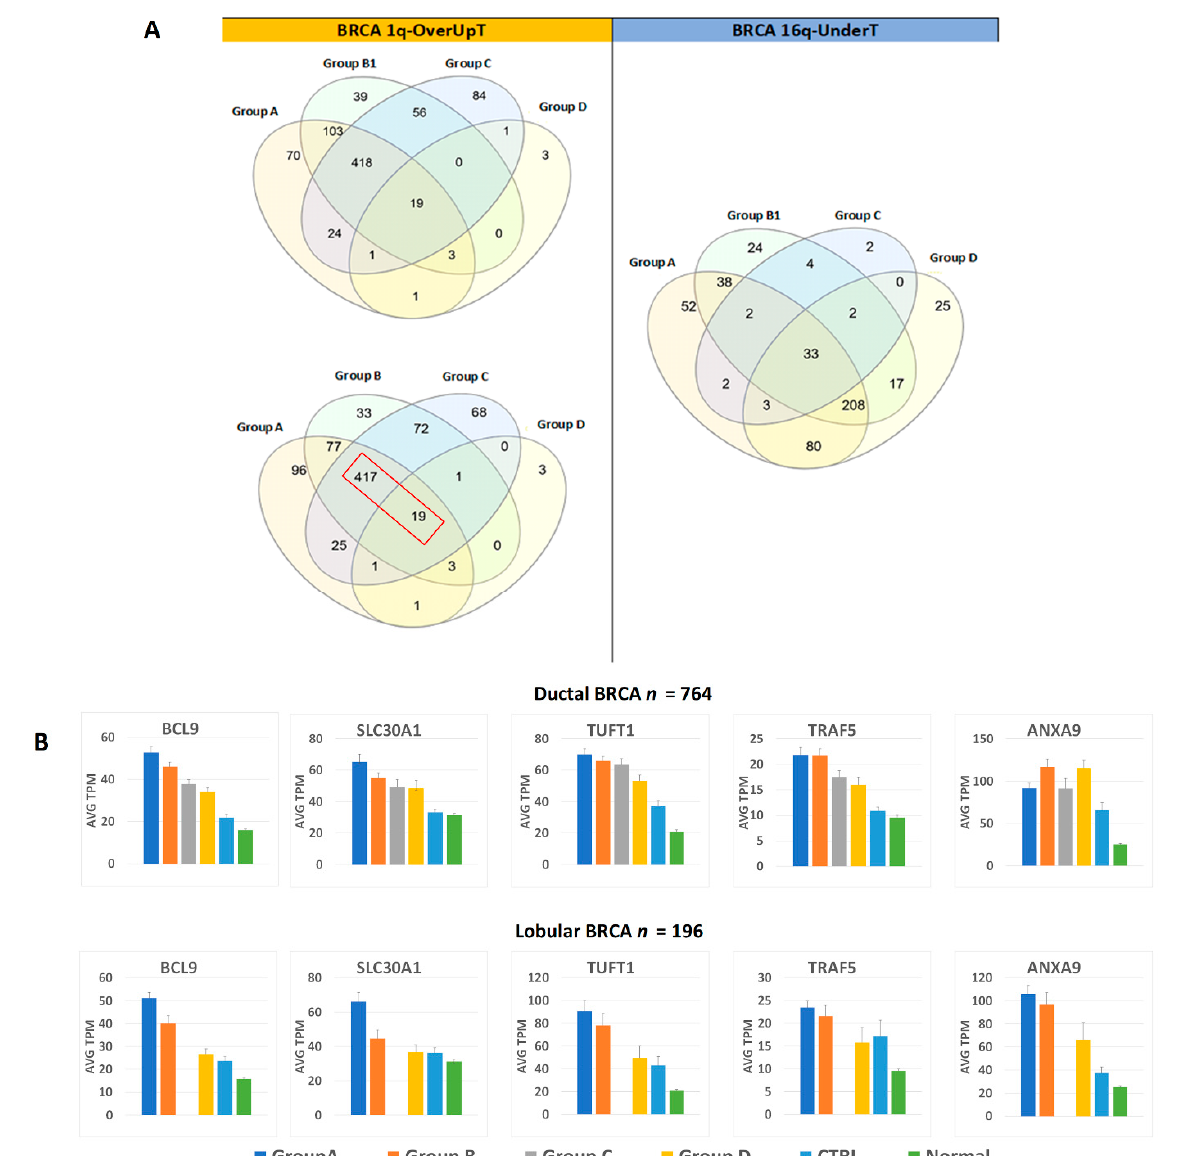
Figure 7. ( A ) Venn diagrams showing the number of shared 1q-OverUpT (transcripts that are overexpressed in comparison to CTRL and upregulated in comparison to normal tissue) (left panel) and 16q-UnderT (right panel) among different 1,16-chromogroups. The 1q-OverUpT shared among groups A, B, and C are indicated by a red box (436 genes). ( B ) Representative core 1q-OverUpT in ductal or lobular breast carcinomas; expression values are reported as averages (AVG) of TPM (transcripts per million) ± SEM. The total number of ductal and lobular cancer samples ( n ) is reported in the graph. Due to the rarity of lobular histotype in group C (one sample), no average value could be calculated and the corresponding column is absent in the graph.